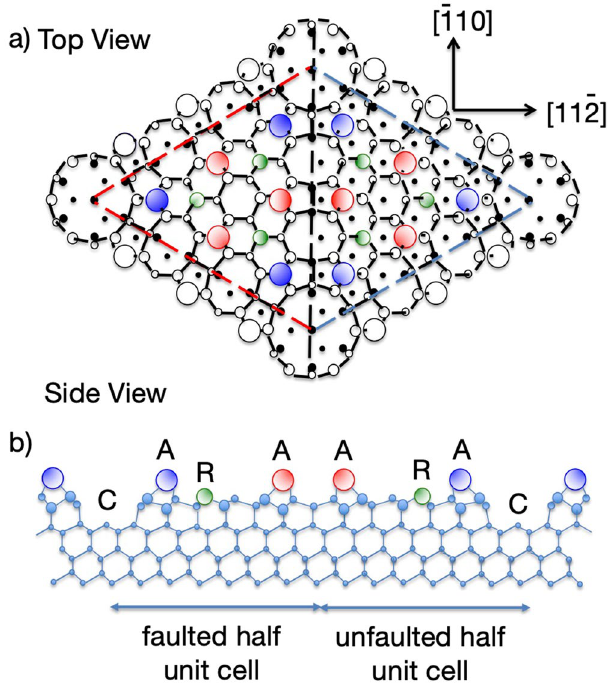
Figure 1. Schematic diagram of the DAS model of the Si(111)(7 × 7) surface showing the adatoms (A), rest atoms (R) and the corner rest atoms (C). The top view shows the different visibility of lower atoms in the two halves of the unit mesh due to the presence of a stacking fault in one